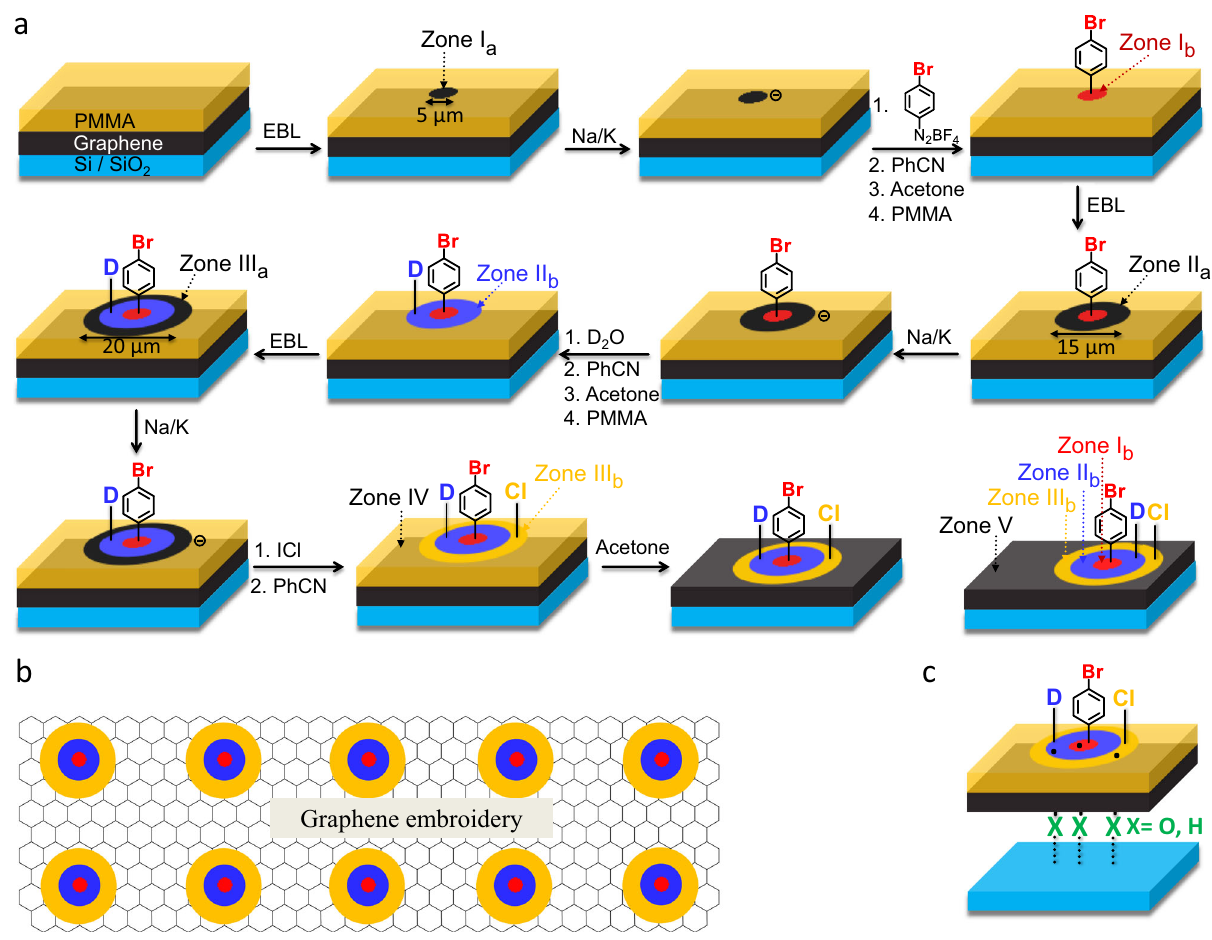
Fig. 1 Reaction sequence towards multiply patterned graphene architectures. a Schematic illustration of the reaction sequence for the multiple patterning functionalization of a graphene monolayer. PMMA: polymethyl methacrylate. EBL: electron-beam lithography; zone I a , II a , and III a : the step-wise EBL exposed graphene areas (black circle with diameters of 5 µ m, black concentric ring with diameters of 15 µ m, and 20 µ m) before functionalization; zone I b , II b , and III b : reagent-accessible graphene areas after activation/functionalization. The fi rst addend zone (zone I b ), showing covalently bound bromophenyl units, is indicated in red; the second addend zone (zone II b ), covalently bound deutero-atoms, is indicated in blue; the third addend zone (zone III b ), covalently bound chloro-atoms, is indicated in orange. Zone IV: PMMA-covered graphene and zone V: intact monolayer graphene after fi nal PMMA removal. Each patterning process includes fi rst spin-coating of a PMMA double-layer mask, and then EBL-based patterning of the graphene – PMMA assembly. The subsequent 2D-functionalization comprises: (1) addition of the trapping electrophile including 4-bromobenzene diazonium- tetra fl uoroborate, deuteroxide, and iodine monochloride to graphene area reductively activated by sodium/potassium (Na/K) alloy; (2) quenching the reaction and the removal of residual charges by the addition of benzonitrile (PhCN); 26 (3) washing with acetone to remove unreacted chemicals as well as the old PMMA coverage. As this reagent leads to a partial degradation of the protective PMMA layer, the old PMMA coverage is removed by acetone. By this procedure, the initially created addend patterns (zone I b , zone II b ) become covered by PMMA, but can be retrieved by the aid of a lithographically applied crosshair pattern, for details see supplementary section S2; and (4) re-spin-coating of a fresh PMMA layer. b Example image of the resulting graphene embroidery via molecular embroidering strategy. c During the entire reaction procedures, strain-free antaratopic additions provided by surface atoms (i.e., O) of the underlying Si/SiO 2 substrate were enabled. Inert substrates would allow only for successive supratopic additions, which however are forbidden due to the enormous amount of strain energy that would be built up 27